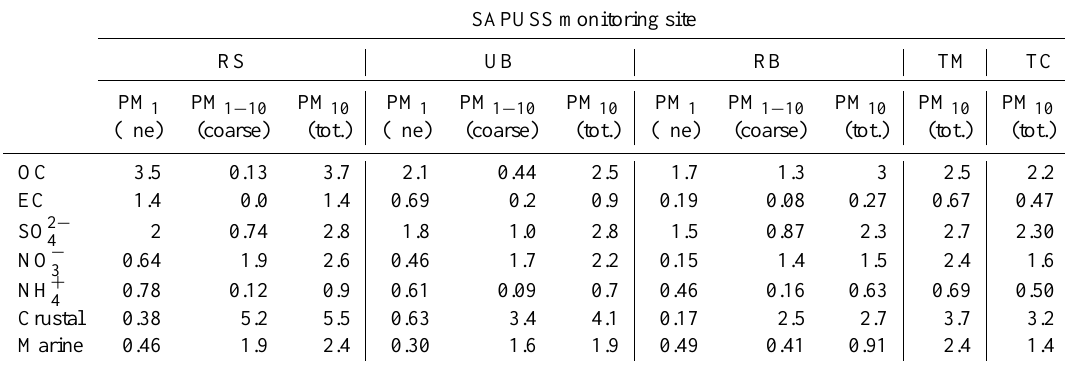
Table 7. Mean concentrations [µgm − 3 ] of 12h resolution measurements from filters of OM, EC, SO 2 − unaccounted mass in PM 1 , PM 1 − 10 , and PM 10 fractions at different SAPUSS monitoring sites (RS, UB, RB). Please note that only PM 10 concentrations are available for the the TM and TCg